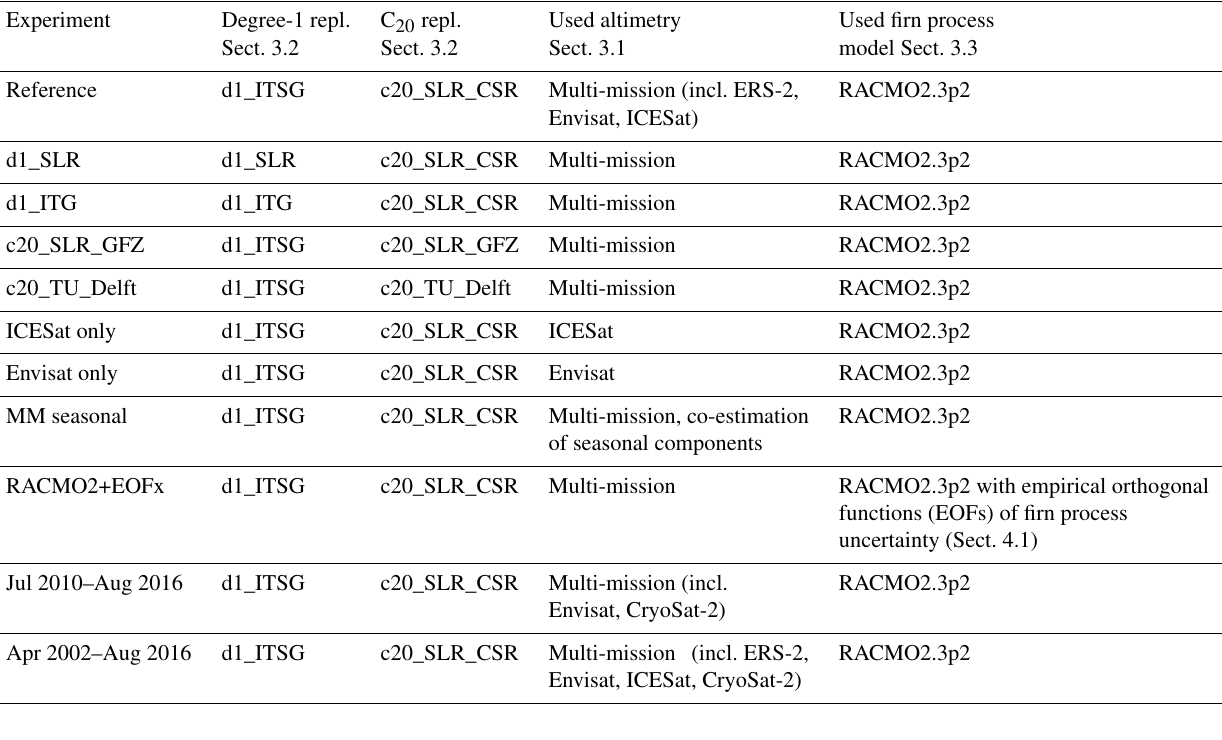
Table 1. Overview of all performed experiments of the sensitivity analysis (Sects. 2.6 and 4.2, Table 2). All experiments use ITSG-Grace2016 monthly solutions (Mayer-Gürr et al., 2016) over the March 2003–October 2009 time period, except for the last two experiments which use the quoted time period.